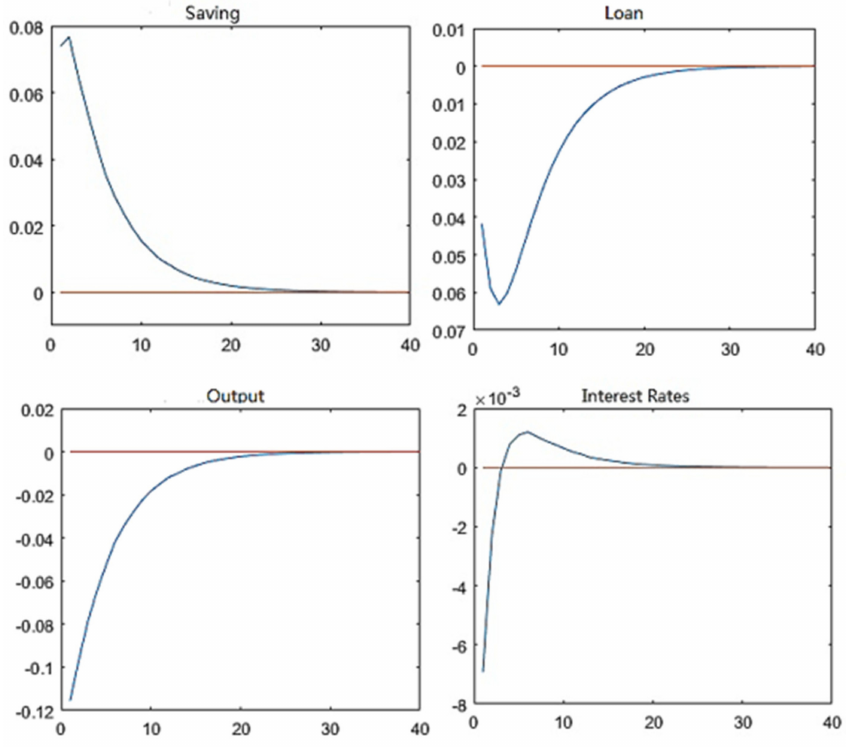
Figure 4. Impulse response results of main variables under price monetary policy (extended model; electronic money suppression shock).